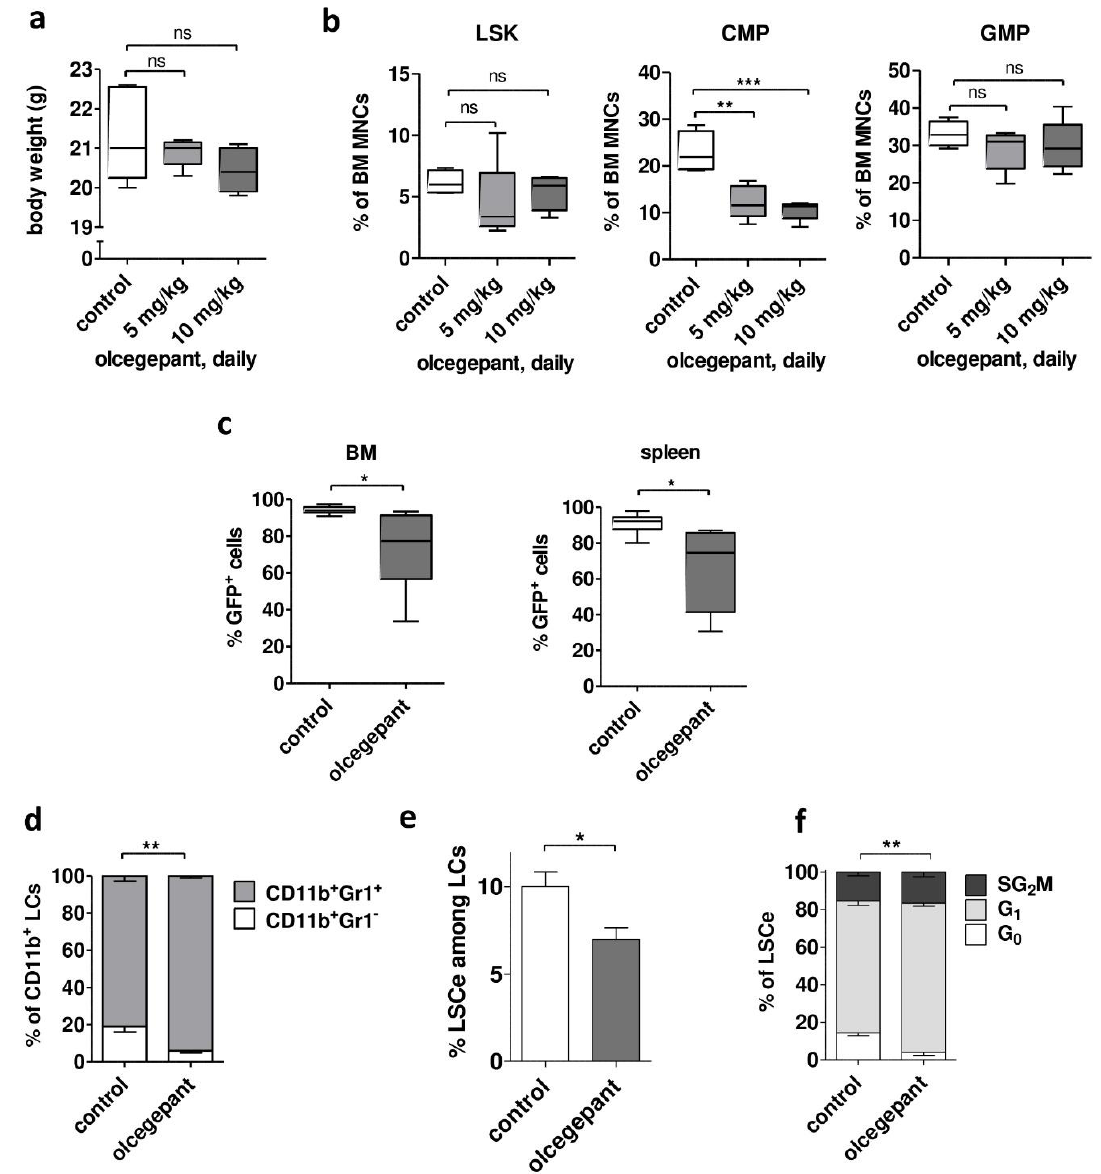
Figure 7: Olcegepant decreases leukemic burden and stem cell properties in a mouse model of AML. ( a, b ) Healthy C57BL/6 mice (4–5 per group) were treated with 0, 5, or 10 mg/kg olcegepant by daily i.p. injection from day 1–14 after a sublethal irradiation. ns, not significant, ** p < 0.01, *** p < 0.001, Student's two-tailed t-test. ( a ) Total body weight at the end of treatment. ( b ) Relative abundance of LSK cells, CMPs, and GMPs among BM MNCs. ( c–f ) C57BL/6 mice were transplanted with LC LSK_MA9 and treated with 0 or 10 mg/kg olcegepant by daily i.p. injection from day 7–18 after transplantation. * p < 0.05, ** p < 0.01, Student's two-tailed t-test. ( c ) Leukemic burden: proportion of Venus + (leukemic) cells in bone marrow (BM) and spleen. n = 6/group. ( d ) Leukemic cell (LC) differentiation: proportion of Gr1 + cells among Venus + CD11b + BM cells. ( e ) Abundance of the LSC enriched Lin - Sca1 - c-Kit + CD34 + CD16/CD32 hi (LSCe) population among leukemic (Venus + ) cells (LCs) in BM. ( f ) Cell cycle distribution of LSCe. Significance indicator refers to G 0 only. ( d-f ) n = 5/group.